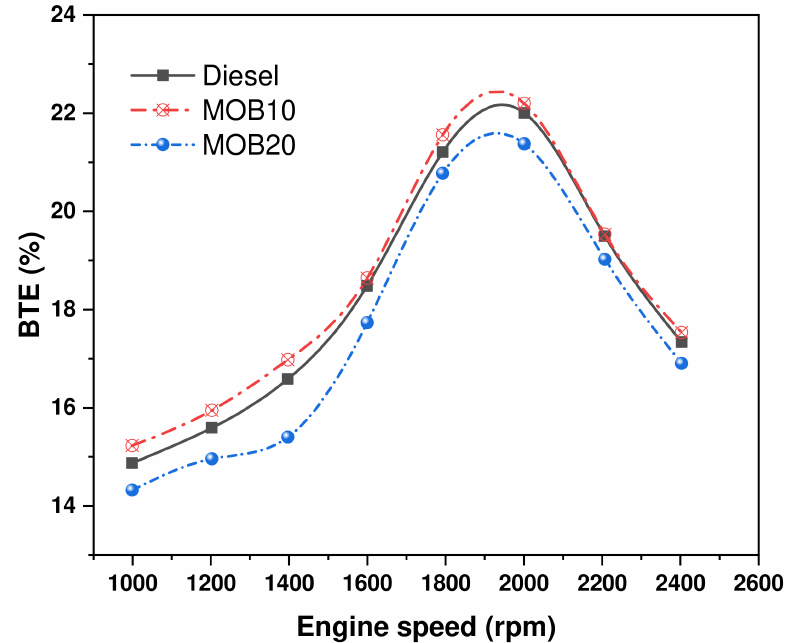
Figure 4. Variation in BTE with varying engine speed for biodiesel blends and diesel.